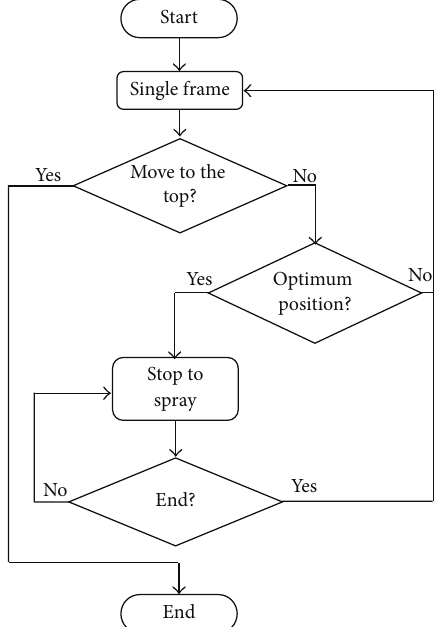
Figure 6: The overall control strategy of servo control